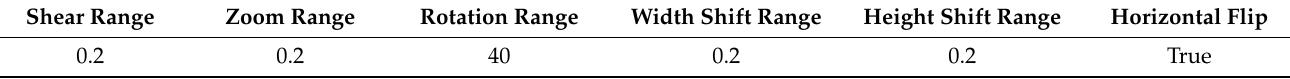
Table 1. Parameters used in data